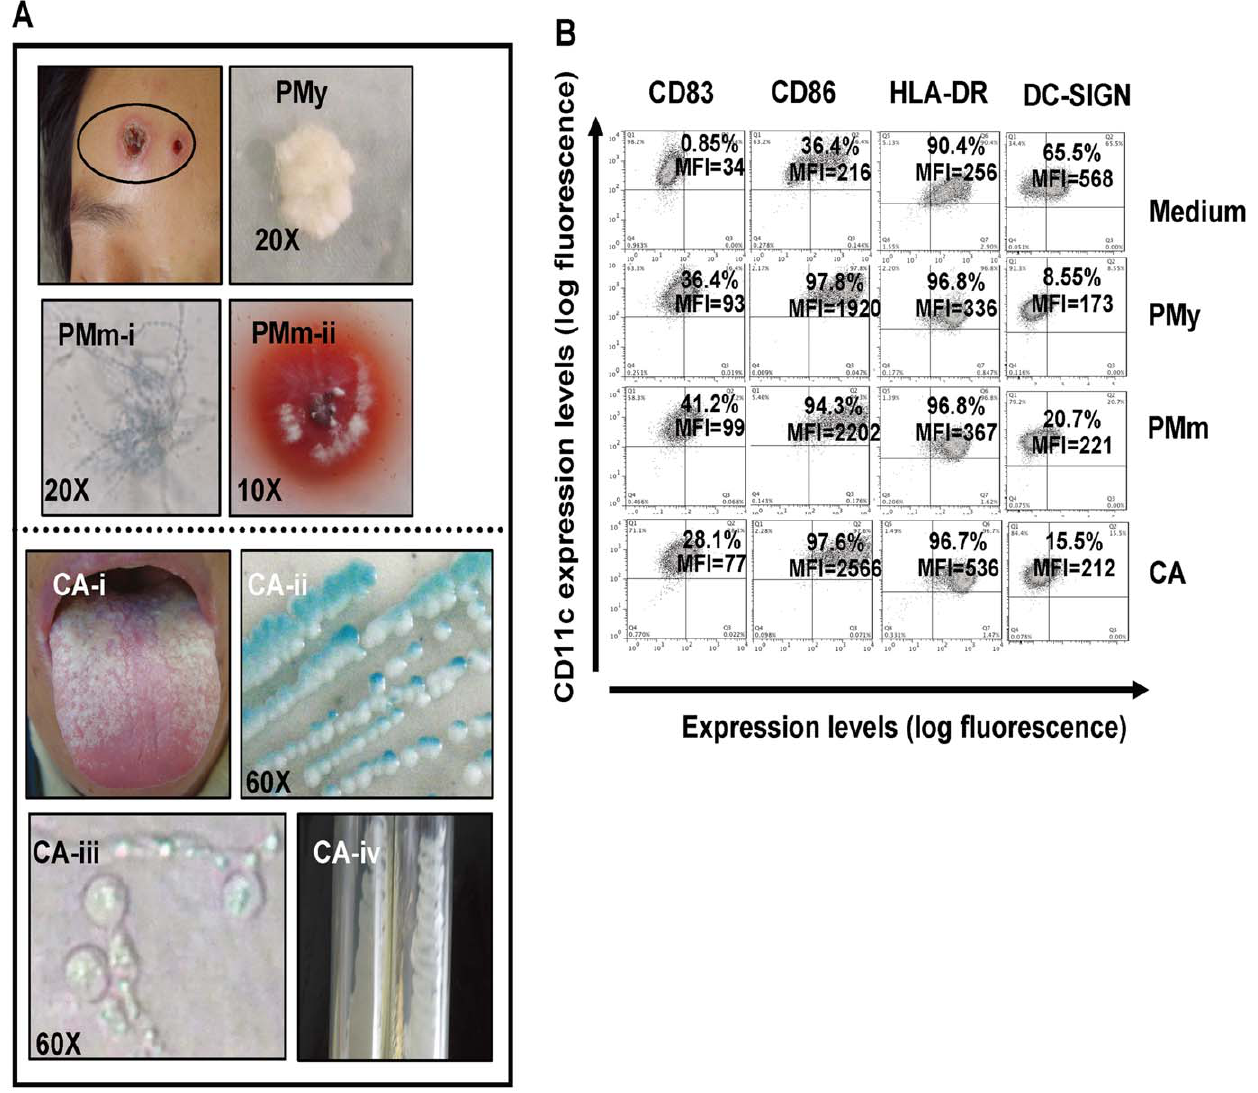
Figure 1. Fungal stimulation induces MDDCs activation. (A) Ex vivo culture and characterizations of fungi species associated with HIV-1 infection. P. Marneffei was isolated and identified from a skin lesion from an AIDS patient. Sub-cultured P. Marneffei showed dimorphisms, with a yeast form at 37 u C growth (PMy) and a mycelial form at 25 u C (PMm-i); the production of red pigments at 25 u C is indicated (PMm-ii). C. Albicans was isolated from the tongue of an AIDS patient (CA-i), and identified with sub-inoculation in CHROMagar Candida displaying the green color (CA-ii), and in Corn Tween agar showing the formation of sporulation (CA-iii), C. albicans was sub-cultured ex vivo (CA-iv). (B) Activation of MDDCs was monitored by flow cytometry. Immature MDDCs were treated with heat-killed C. albicans , PMy and PMm at a ratio of 1:10 for 48 h, and medium treatment was used as a control. MDDCs were gated as a CD11c + population, and fungus-stimulated MDDCs showed increased expression of HLA-DR and the co-stimulatory molecules CD83 and CD86, with decreased expression of DC-SIGN, compared with the medium-treated controls. The positive percentages and values of MFI from one representative out of six experiments are indicated.